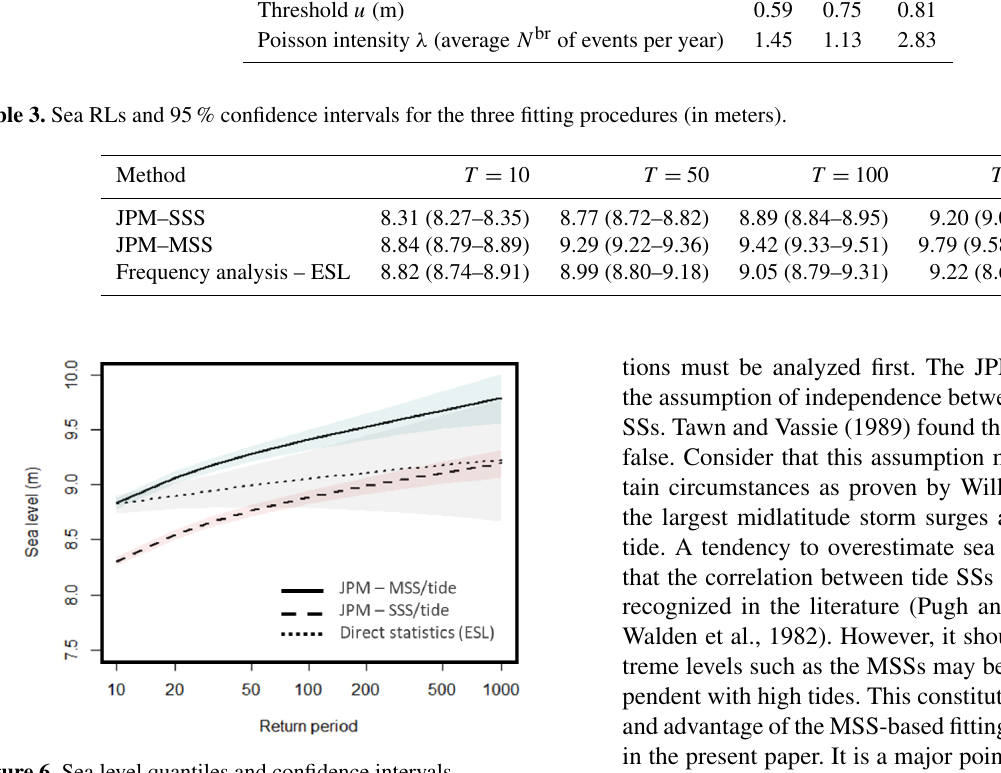
Figure 6. Sea level quantiles and confidence